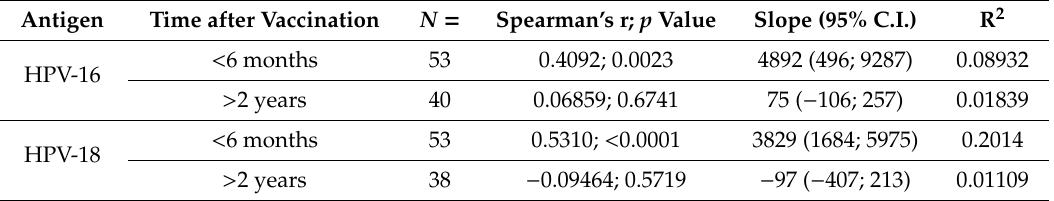
Table 1. Correlation between antigen specific IgG titers and memory B cell